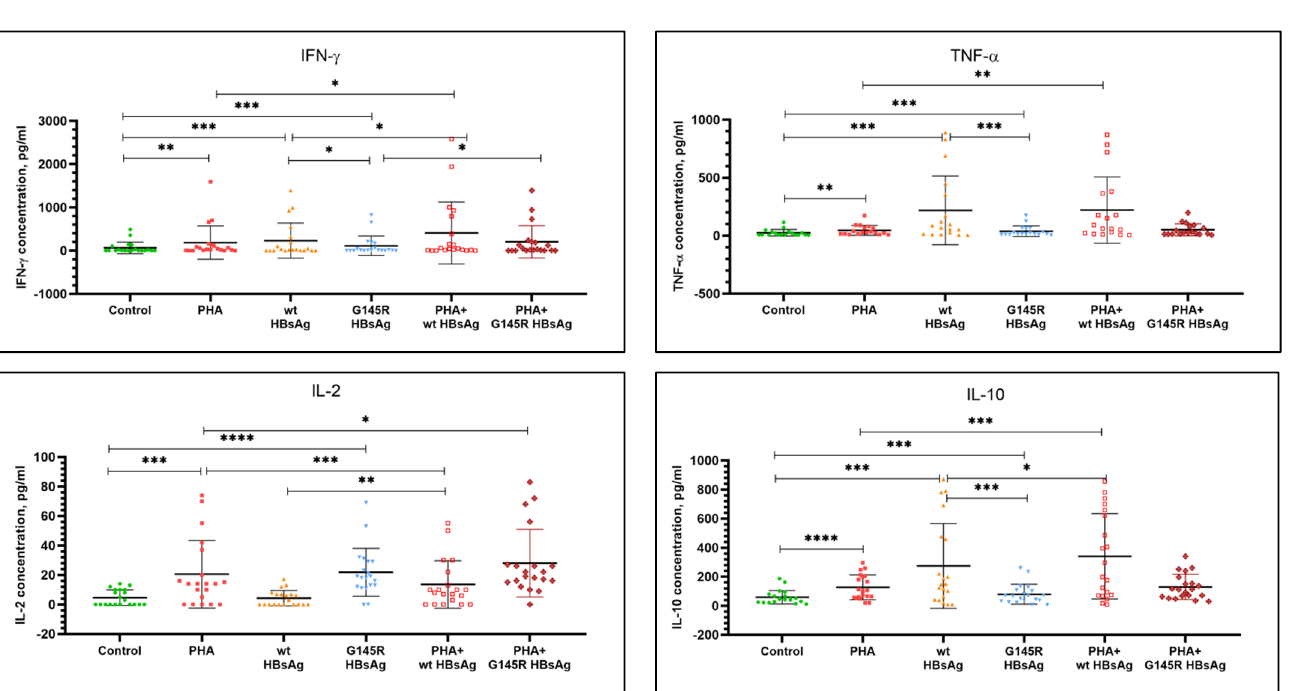
Figure 4. Assessment of cytokine production by PBMC following stimulation with wild-type rHBsAg, the rHBsAg G145R mutant, or PHA, or their combinations. Significant p values are reported as asterisks, where * p ≤ 0.05, ** p ≤ 0.01, *** p ≤ 0.001, and **** p ≤ 0.0001.